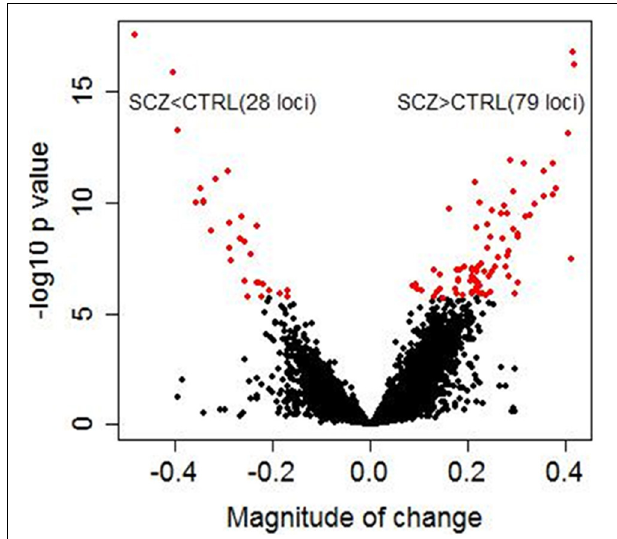
FIGURE 1 | Diagnostic differences in DNA methylation. The x axis represents magnitude of a change (beta value) between controls and schizophrenia subjects calculated by linear regression analysis in 216 samples. The y axis represents − log 10 p- values. Each dot represents an individual CpG site (a total of 25,156 CpG sites). Red dots represent 107 CpG sites that showed significant diagnostic differences between schizophrenic subjects and controls (5% Bonferroni correction). Magnitude of change > 0 corresponds to higher methylation in patients with schizophrenia than in controls, whereas magnitude of change < 0 corresponds to lower methylation in patients with schizophrenia than in controls. Of these 107 CpG sites, 79 sites (73.8%) demonstrated higher methylation in patients with schizophrenia than in